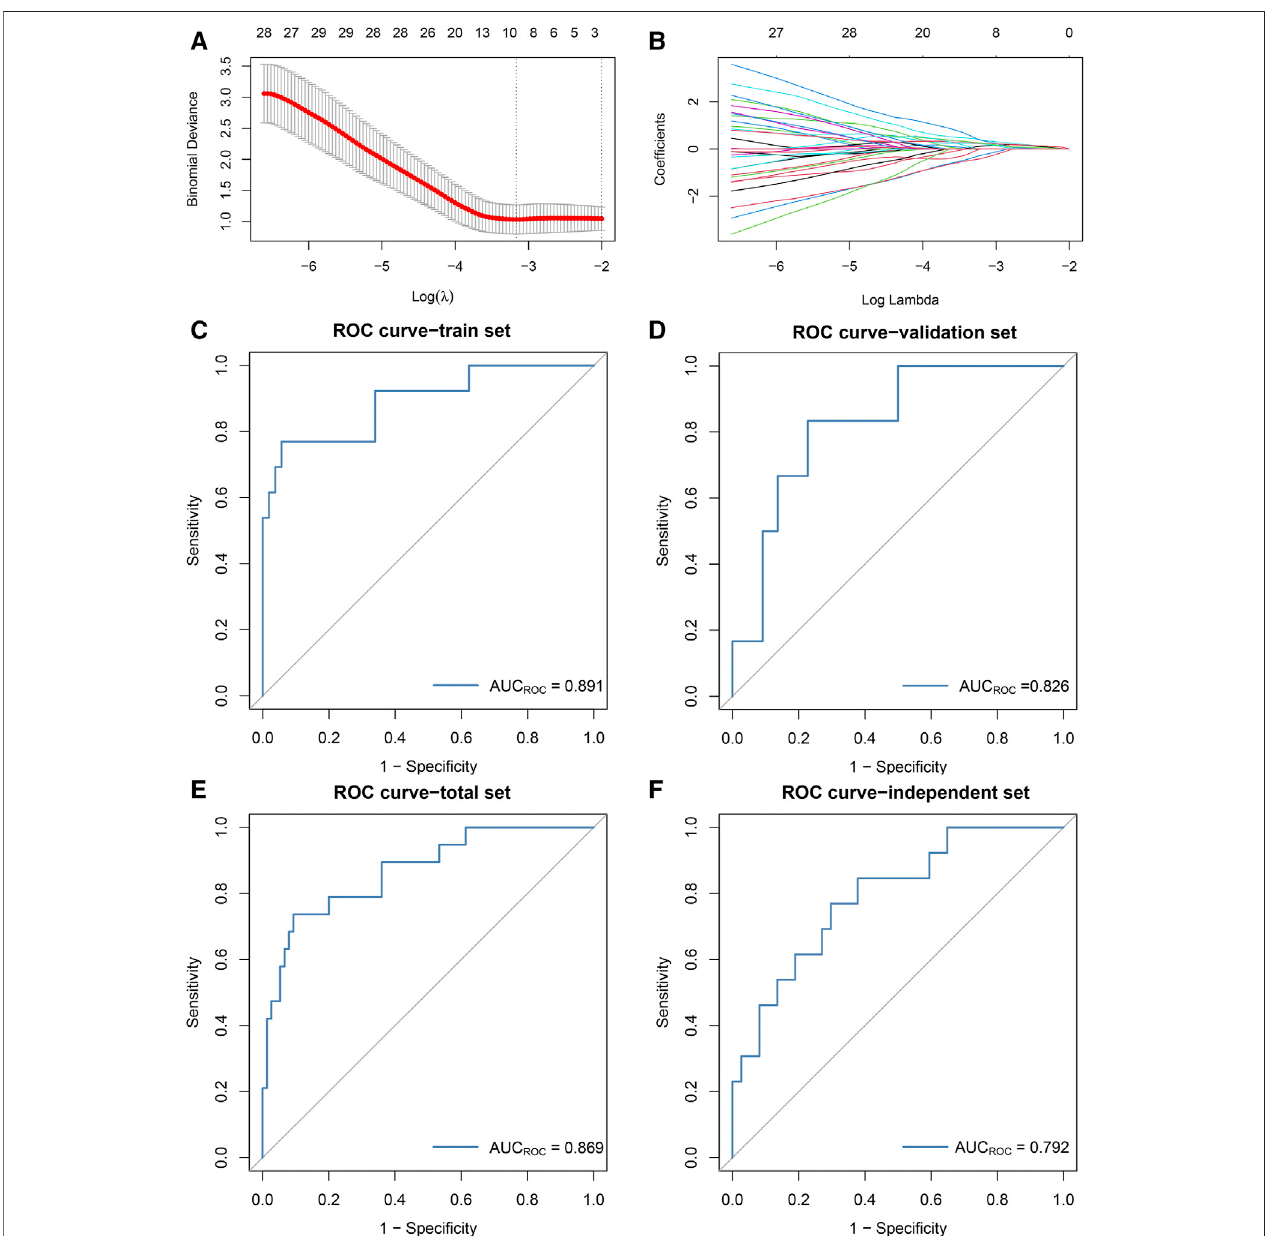
FIGURE 5 | The development and validation of the diagnostic model based on the random forest and LASSO regression algorithms. (A) : The log( λ ) value was optimallyselectedby5-fold cross-validation andplottedbythepartiallikelihooddeviance. (B) :TheprocessesofLASSOregressionforscreeningvariablesandmapping eachvariabletoacurve. (C – F) :ROCcurveswereusedtopredictischemiceventsafterCEAinthetrain[ (C) :AUC=0.891],validation[ (D) :AUC=0.826],total[ (E) :AUC= 0.869] sets and independent cohort [ (F) : AUC = 0.792].